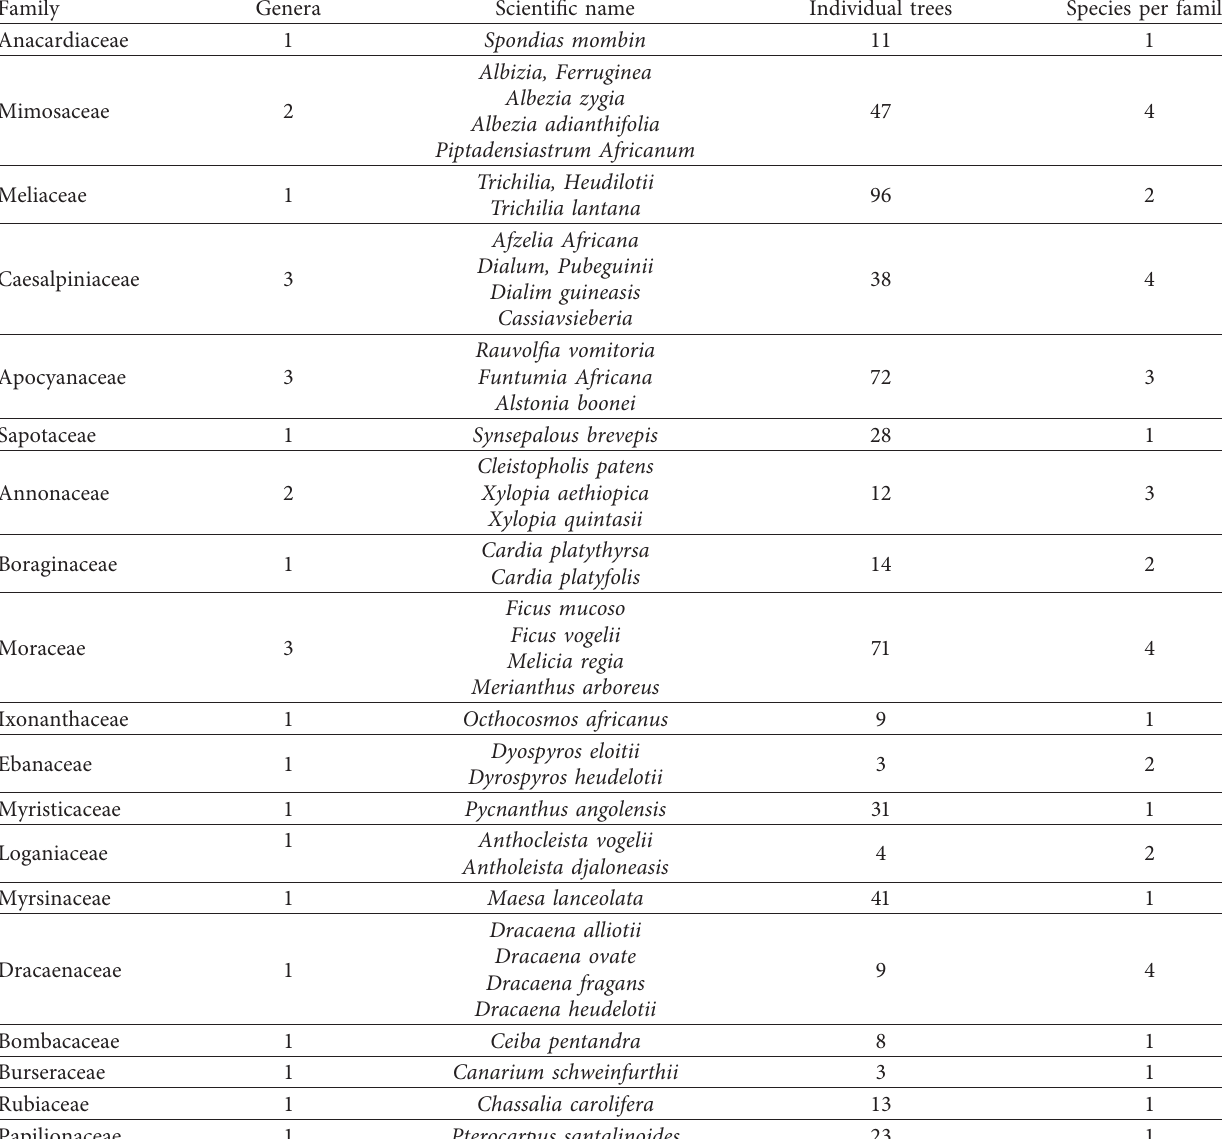
Table 3: Numbers of individual species collected, their plant families, and botanical